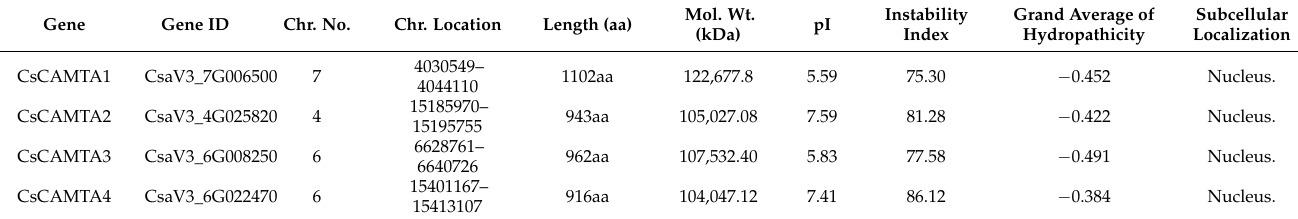
Table 1. Characteristics of CAMTA transcription factors in cucumber.